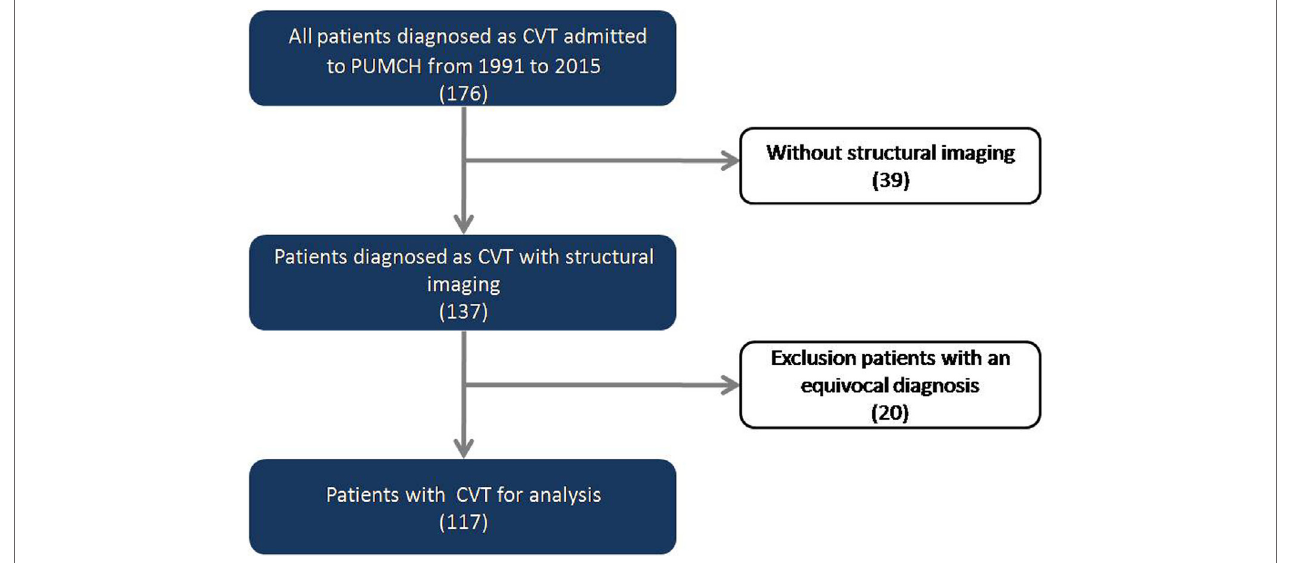
FigUre 1 | Flowchart of the screening process for identifying patients with cerebral venous thrombosis